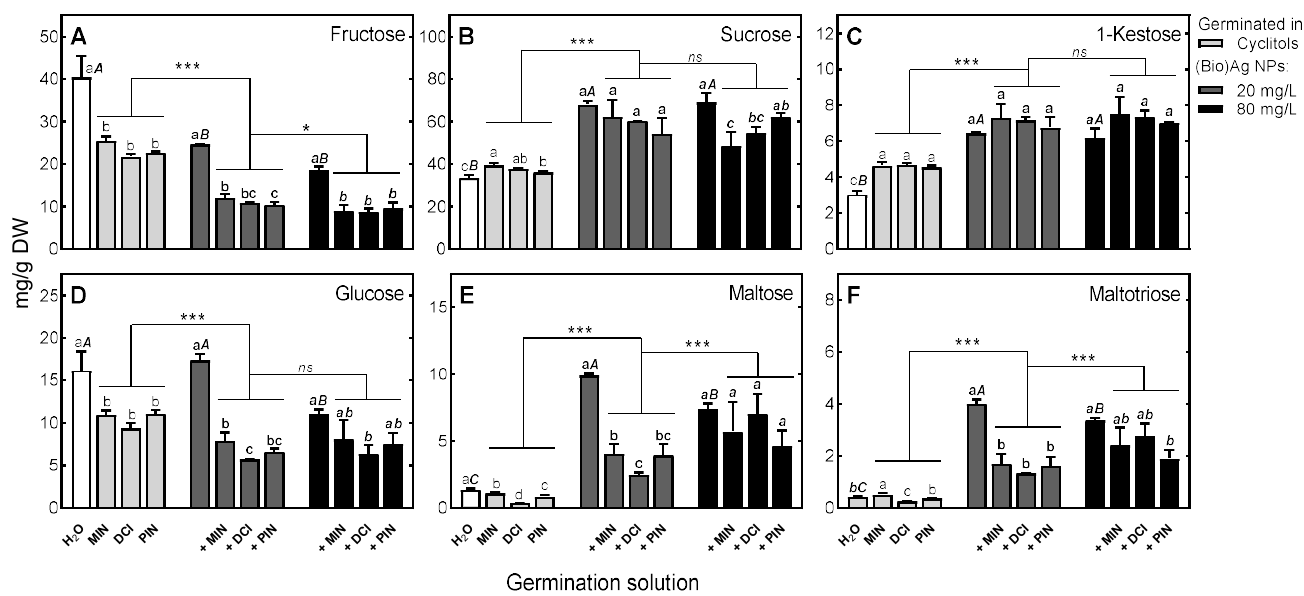
Figure 5. The effects of (Bio)Ag NPs (at 20 and 80 mg/L) and their mixtures with 100 mM myo -inositol (MIN), D - chiro -inositol (DCI) and D -pinitol (PIN) on soluble carbohydrate contents in 3-day-old wheat ( Triticum aestivum L. cv. Ostka Strzelecka) seedlings: ( A ) Fructose , ( B ) Sucrose , ( C ) 1-Kestose , ( D ) Glucose , ( E ) Maltose , ( F ) Maltotriose . Values are means ( n = 3) + SD. Bars with the same letters (a–d) were not significantly ( p < 0.05) different after ANOVA test and Tukey’s post hoc corrections, whereas one to three asterisks (*, ***) denote significant differences (at p < 0.05 and 0.001) between effects of cyclitols alone and in mixtures with (Bio)Ag NPs.